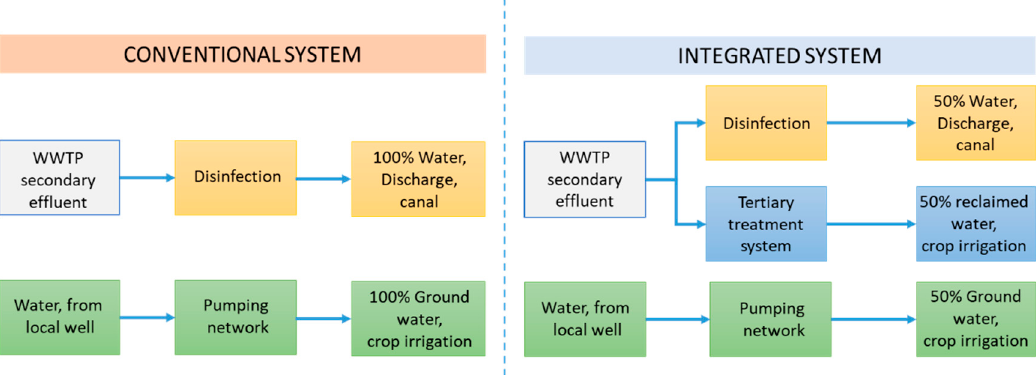
Figure 3. Overview of the assessed water supply options.